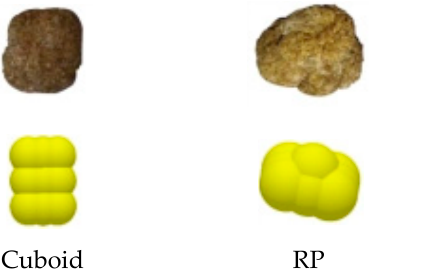
Figure 3. Four different shapes of pig manure and its particle models. The meaning of codes: RP (rectangular pyramid), RRP (right rectangular pyramid), TP (triangular pyramid).